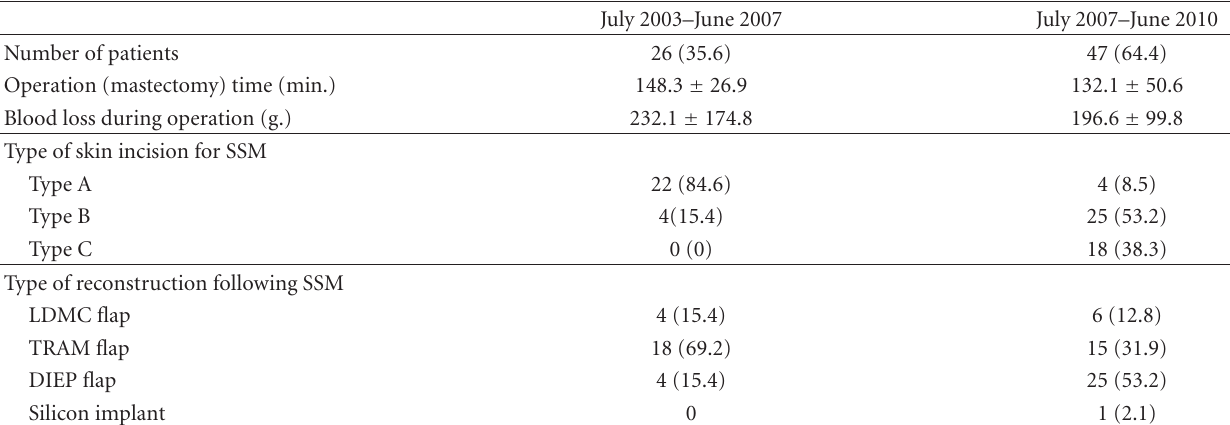
Operation (mastectomy) time